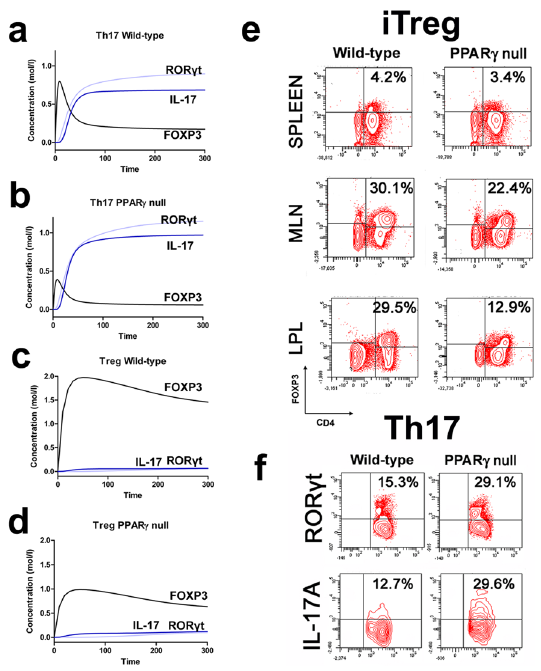
Figure 3. Peroxisome proliferator-activated receptor (PPAR) c suppresses T helper (Th)17 cell differentiation and upregulates FOXP3 expression invivo . (A–D) Computational simulation of the effect of PPAR c deficiency on differentiation from a naı¨ve state into either Th17 or iTreg phenotypes. (E) Th17 cell accumulation in spleens of recipients of wild-type versus PPAR c null CD4 + T cells. (F) Treg cell accumulation in spleen, mesenteric lymph nodes (MLN) and lamina propria (LP) of SCID recipient mice.